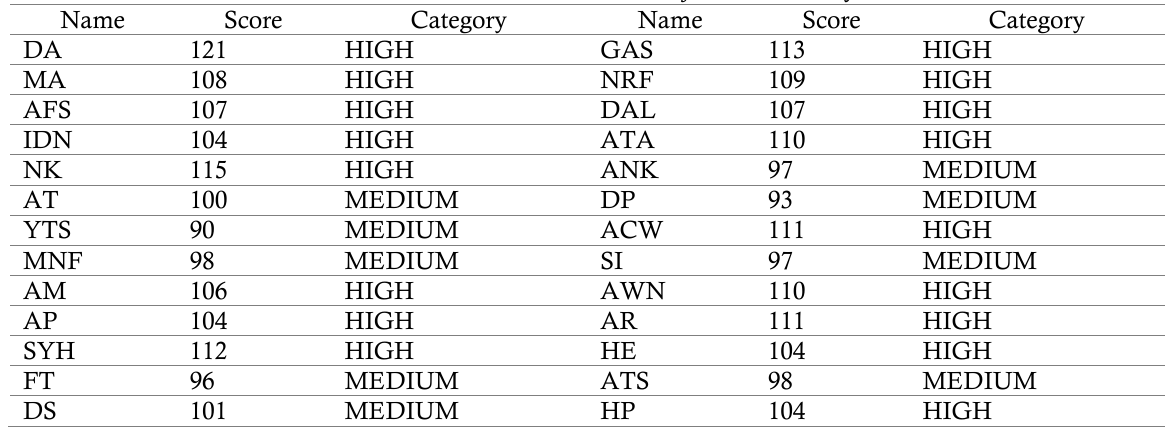
Table 2. Post-testResult of the Subject of the